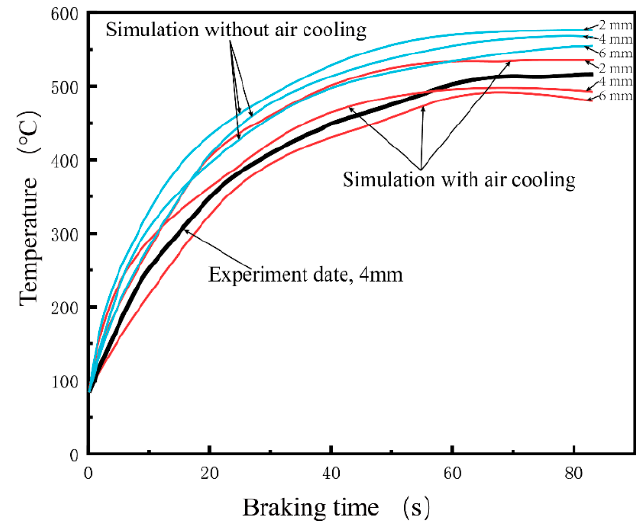
Figure 11. Variation of the maximum friction temperature on the wear-resisting layers of the brake discs with different thickness of wear-resisting layer versus braking times (IBV = 97 m/s). discs with di ff erent thickness of wear-resisting layer versus braking times (IBV = 97 m /